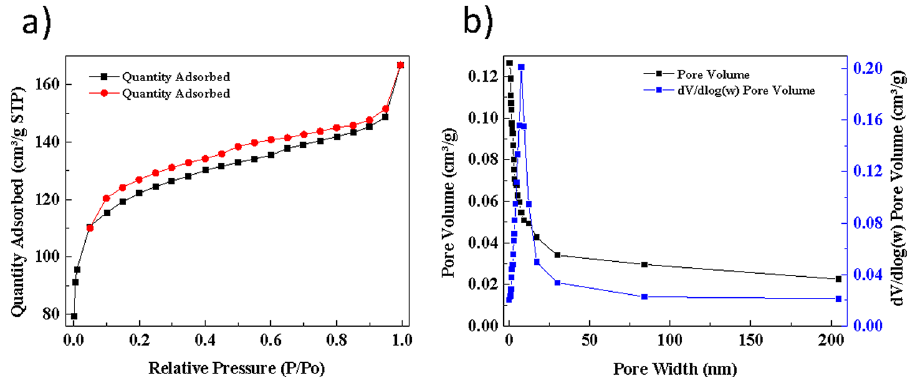
Figure 4. ( a ) N 2 adsorption/desorption isotherms. ( b ) Pore size distribution and pore volume of raw Cu(OH) 2 - NWs-PVA-AC.